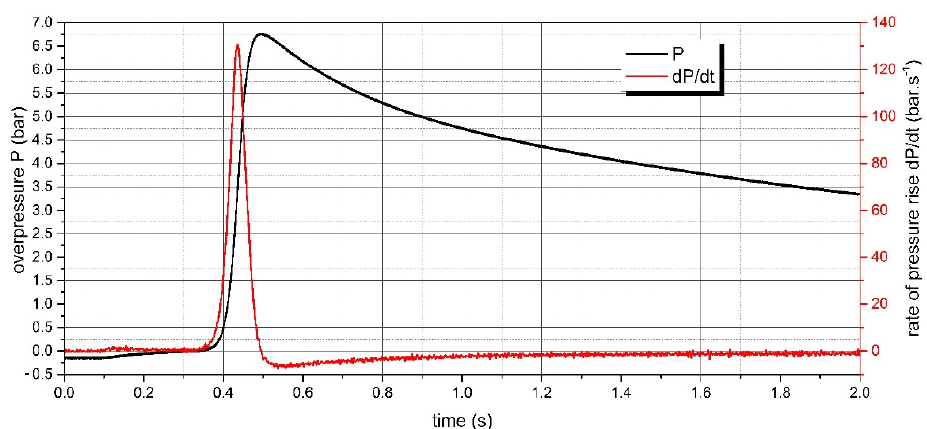
Figure 9. Pressure record of PA12 polyamide explosion at concentration 750 g·m -3 .